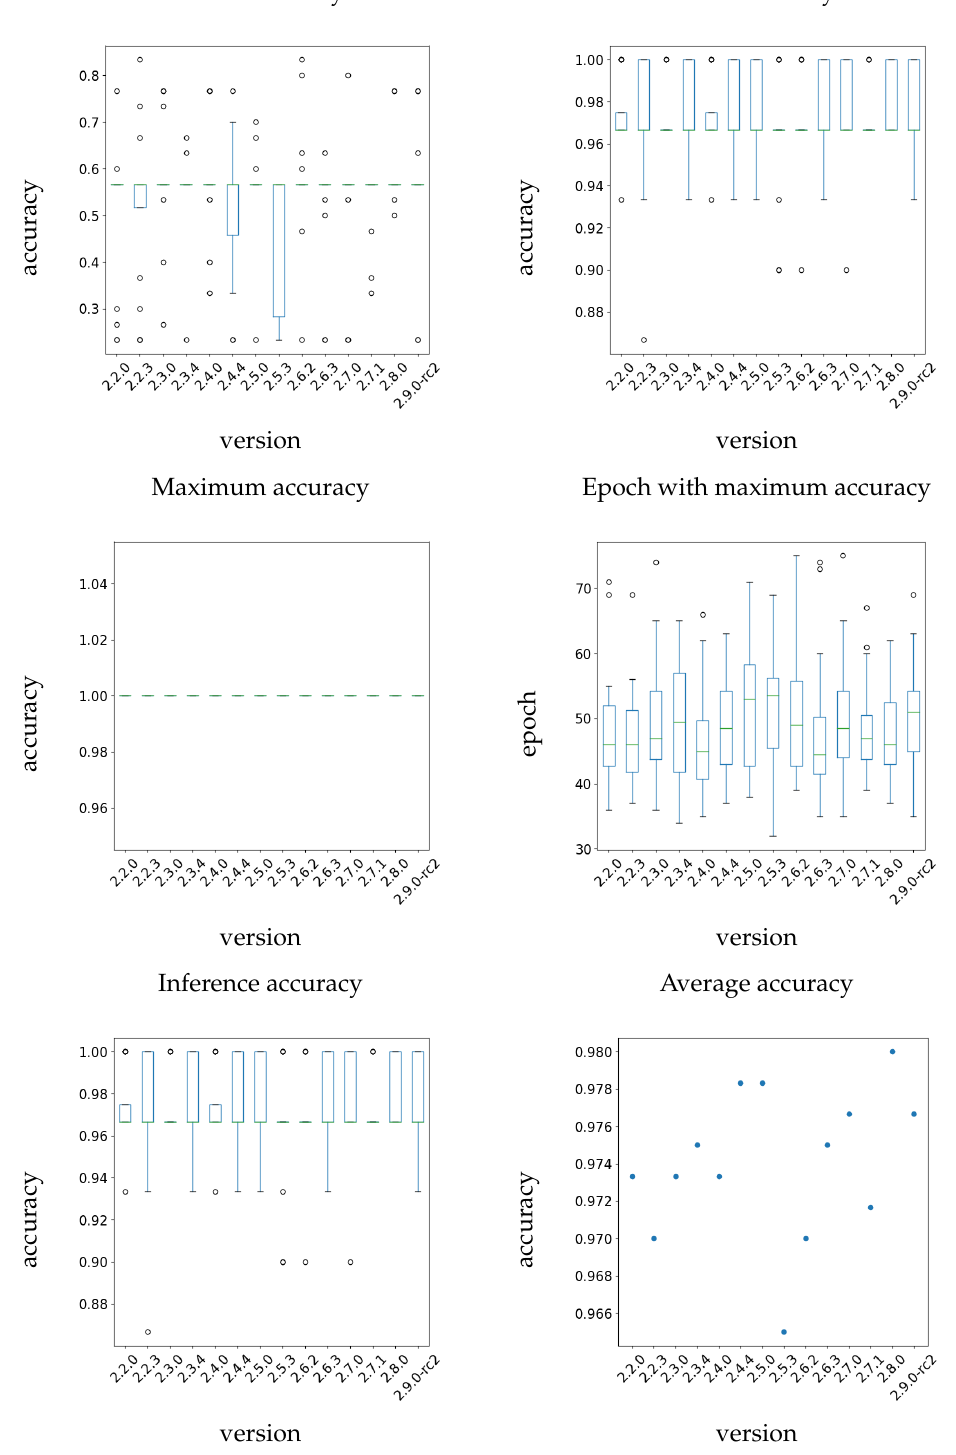
Figure 3. The results for the Iris dataset using